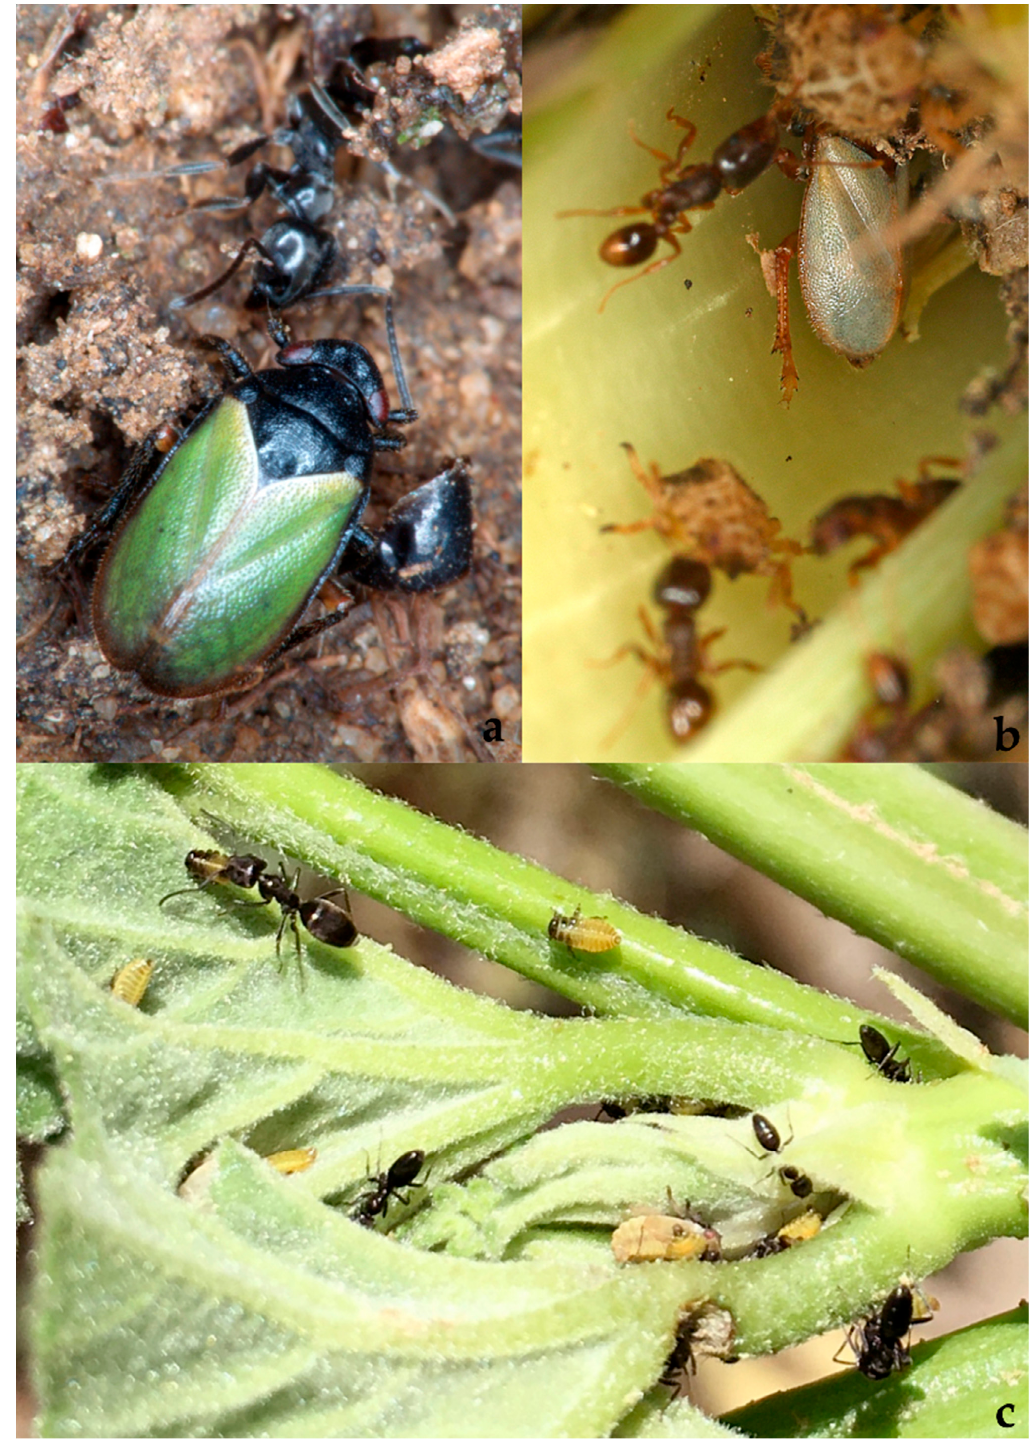
Figure 30. Tettigometridae: ( a ) Tettigometra ( Tettigometra ) laeta Herrich-Schäffer, 1834 tended by Formicidae: Dolichoderinae: Tapinoma erraticum (Latreille, 1798), Bulgaria: Eastern Rhodopes, Zhelezino vill., 41°26 ′ 60 ″ N 25°56 ′ 51 ″ E, 30.03.2012, adults in soil ant nests under stones, obs. I. Gjonov, A. Lapeva-Gjonova; ( b ) T. ( Tettigometra ) laeta tended by Formicidae: Myrmicinae: Tetramorium chefketi Forel, 1911, Albania: Strëmbec, 40°09 ′ 24.8 ″ N 20°28 ′ 26.0 ″ E, 17.06.2019, nymphs and adults on Asteraceae, obs. G. Kunz; ( c ) T. ( Tettigometra ) picta Fieber, 1865 tended by Formicidae: Dolichoderinae: Tapinoma nigerrimum (s.l.), Malta: Il-Kalanka bay, 35°49 ′ 29.0 ″ N 14°33 ′ 23.3 ″ E, 02.06.2019; nymphs and adults on Lavatera arborea L. (Malvaceae), obs. I. Gjonov, A. Lapeva-Gjonova.